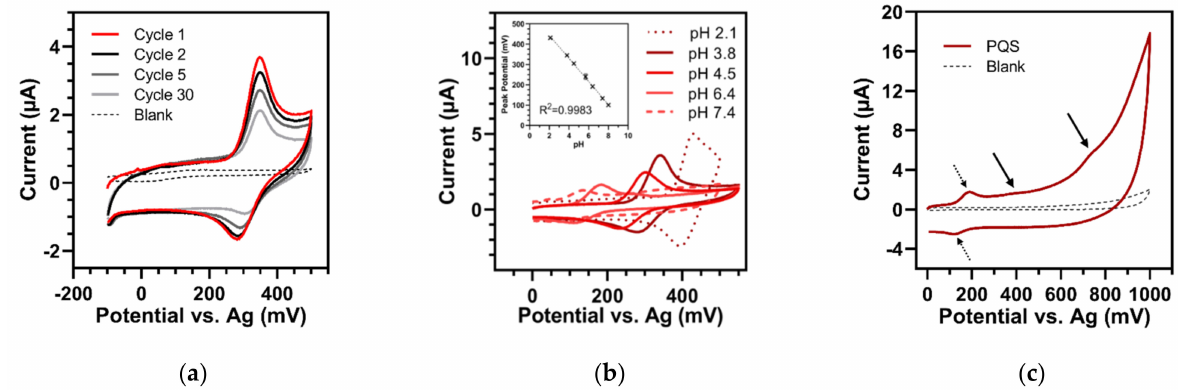
Figure 1. Cyclic voltammetry of 250 µ M PQS (100 mV/s). ( a ) First 30 cycles in buffer of pH 3.8. The intensity of the redox reaction decreased from the first (red) to the repeated cycles (black to light grey). Blank = pH 3.8 buffer. ( b ) Dependency of peak potential on pH of the buffer solution. Insert: Linear regression of oxidation peak potential versus pH in the whole measurable spectrum (pH 2.1 to 8.0). Error bars represent the standard deviations of three replicates. ( c ) Performance of PQS in wide measurement range from 0 to 1000 mV (pH 6.4). Arrows show the quasi-reversible redox couple (at +191/+114 mV) (dashed) and the additional oxidation waves at approx. 410 and 740 mV (full). Blank = pH 6.4